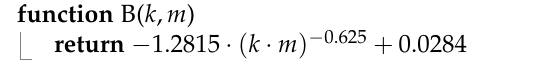
Algorithm 2 Body weight adjusted by correction factor